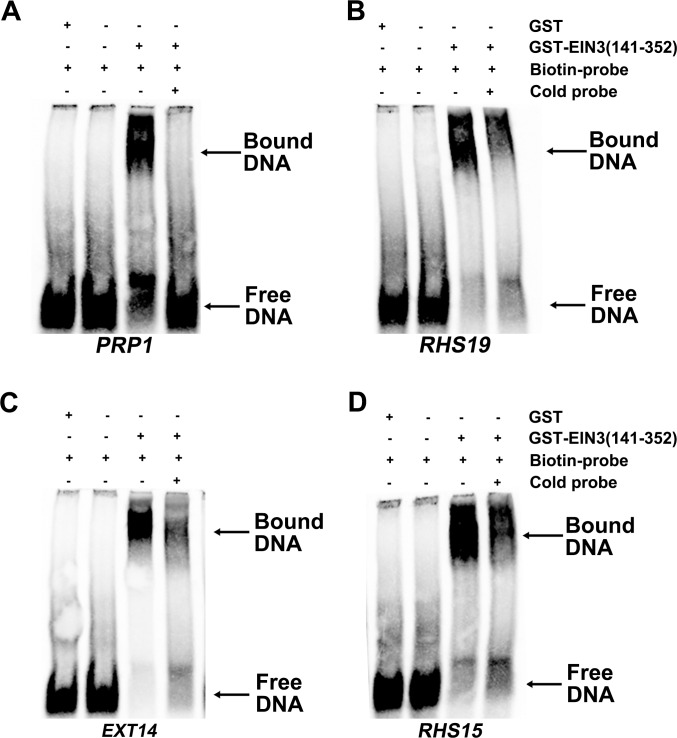
EMSA assays showing the binding of EIN3-GST to the EIN3-binding sites of the promoters of four selected genes.The gene names are indicated at the bottom of each panel. They are PRP1 (A), RHS19 (B), EXT14 (C), and RHS15 (D). The experiment was performed using 0.1 μg of EIN3-GST or GST proteins. The biotin-labelled probe contained 10 fmol of the EIN3-binding element. The 500 X excess unlabeled probe (cold probe) was used as a competitor.